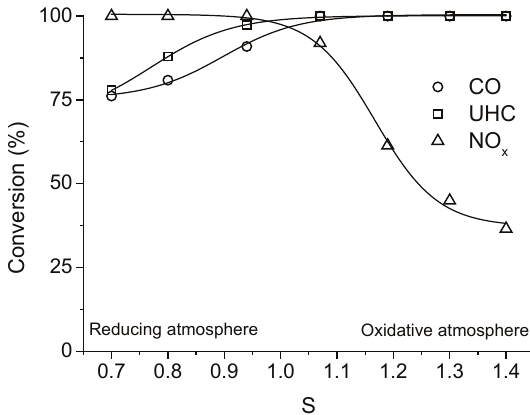
Rh O at 400 °C and 13,000 h − 1 as a function 0.976 0.024 3+δ . Adapted with permission from �𝑆 =